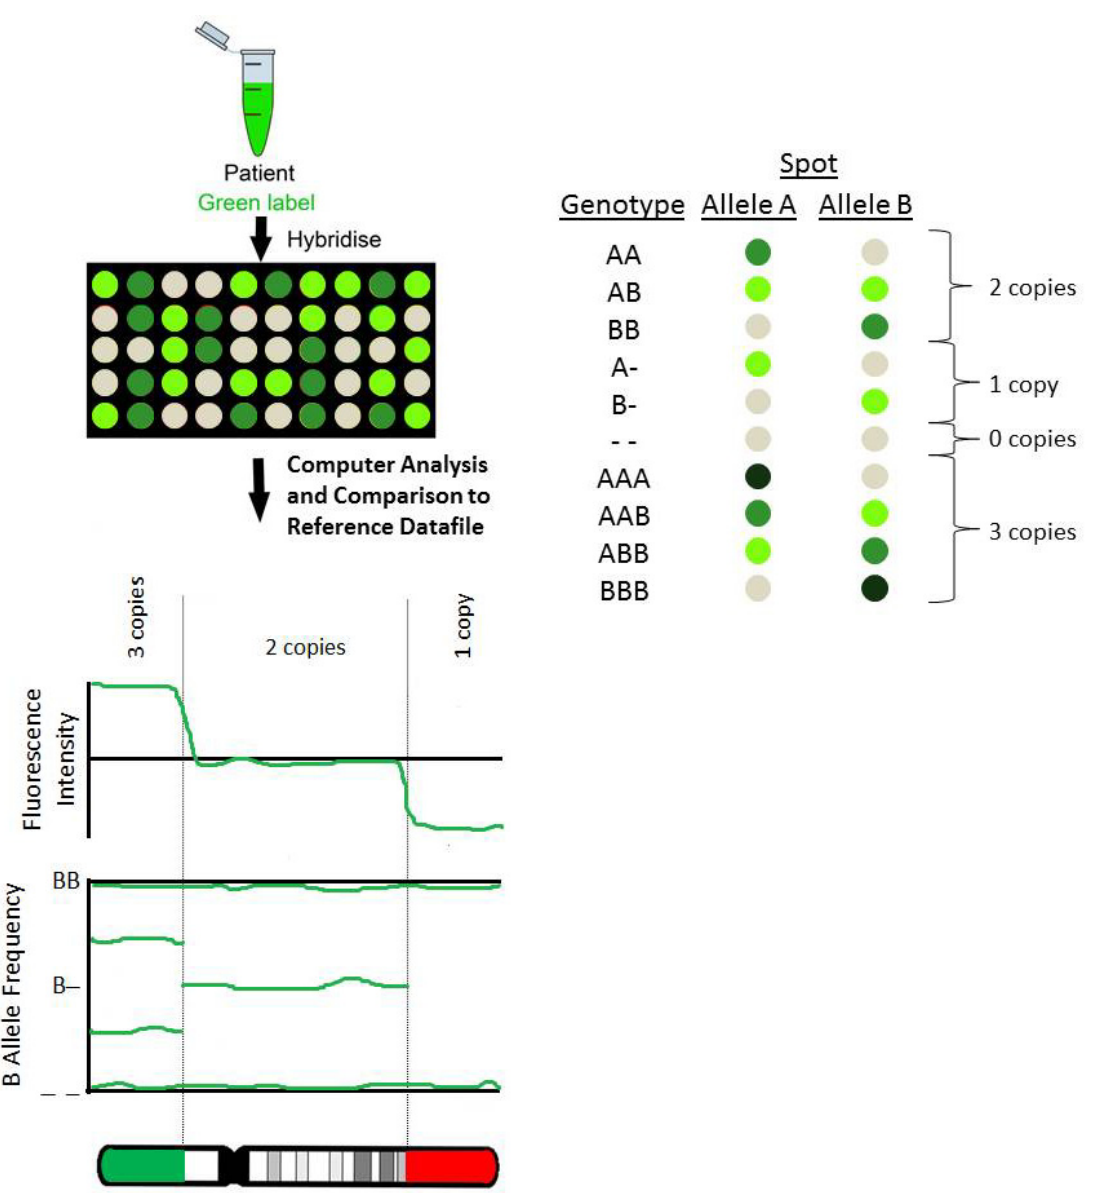
Figure 2. Single Nucleotide Polymorphism (SNP)